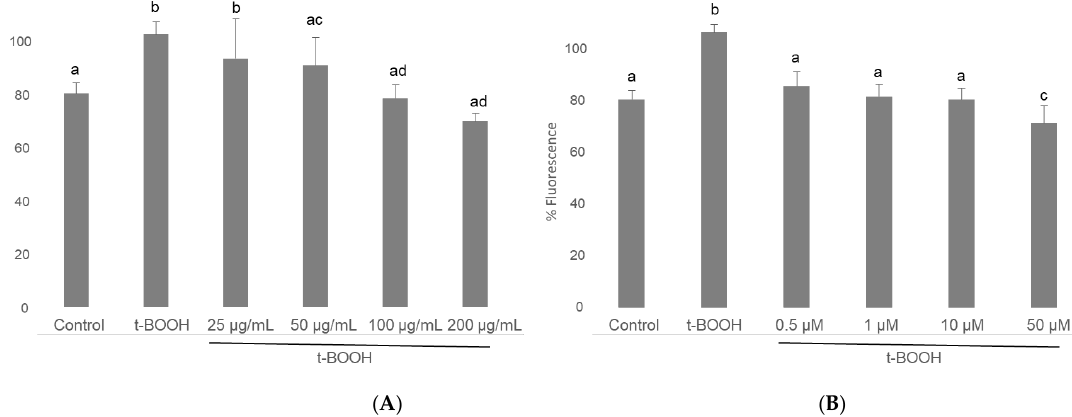
Figure 2. Effect of pre-treatment of differentiated SH-SY5Y cells with cocoa extract ( A ) and EC ( B ) prior to oxidative stress on ROS generation determined by in situ fluorimetry on plated cells. Values are means ± SD, n = 8. Values are expressed as a percent relative to control condition. Different letters indicate statistically significant differences ( p < 0.05) among groups.